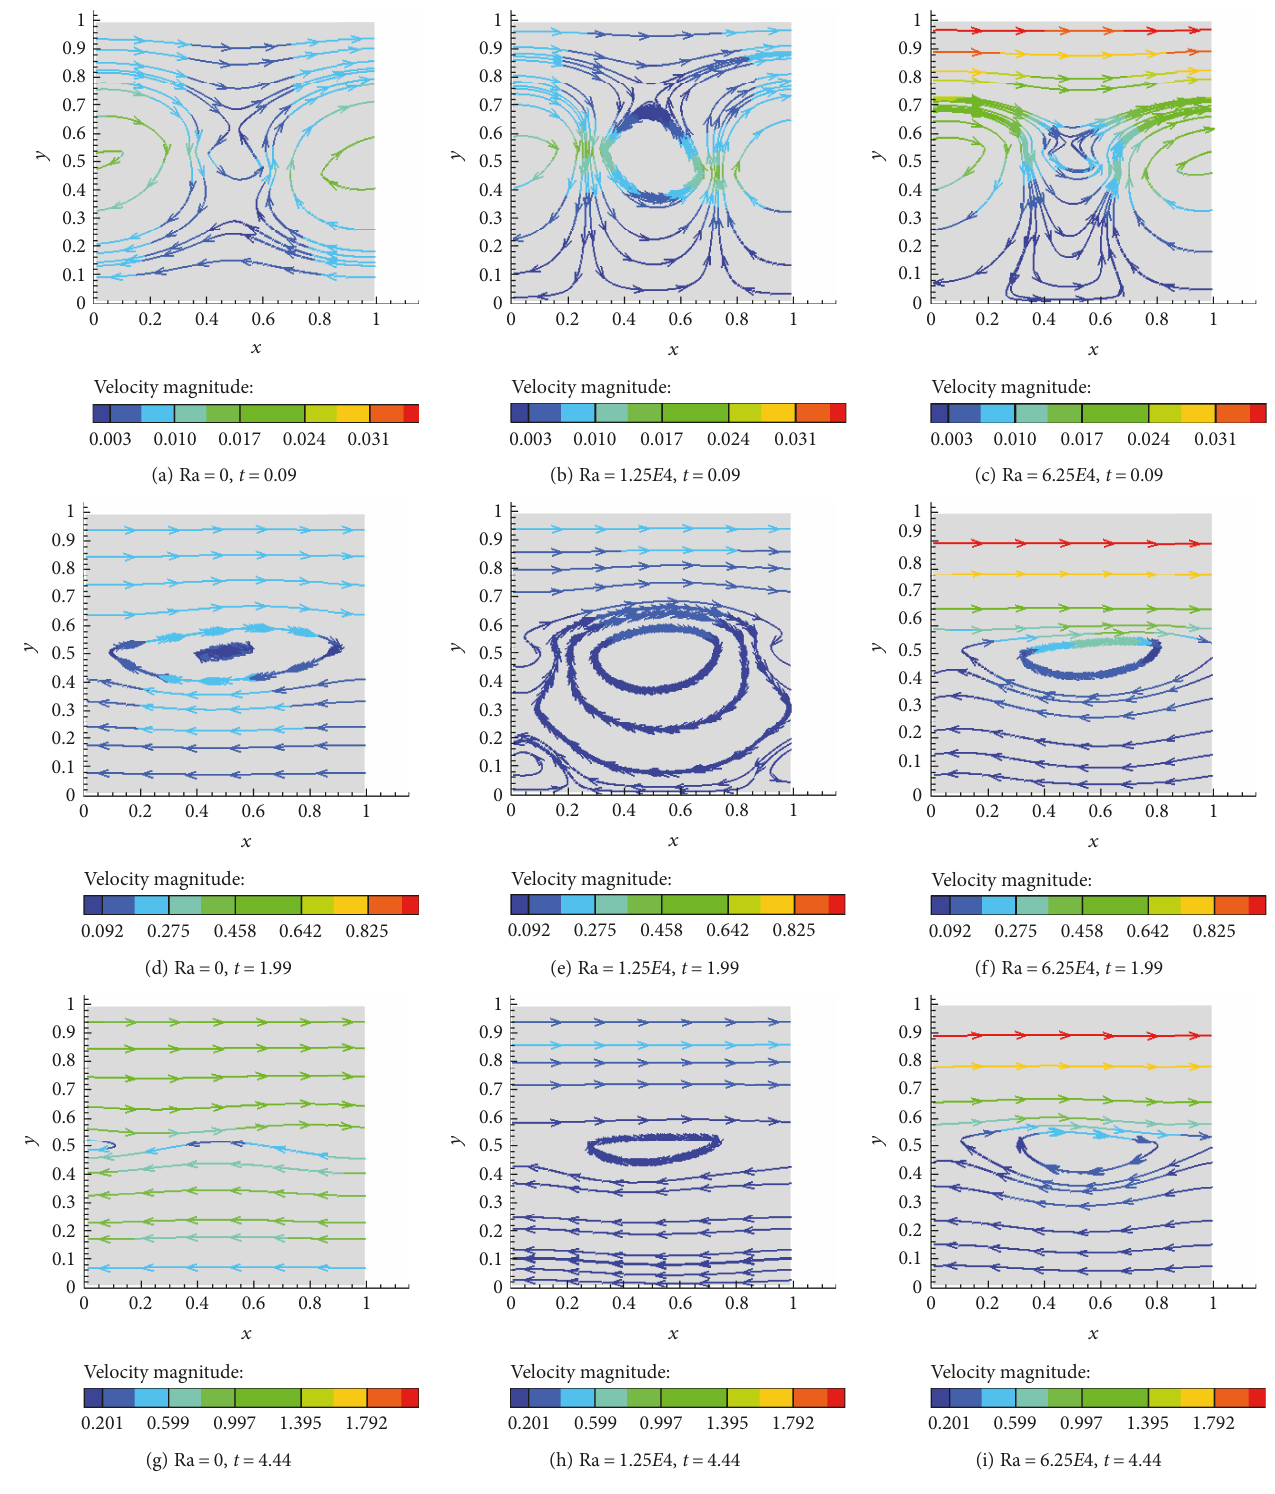
Figure 6: Streamlines in di ff erent Ra